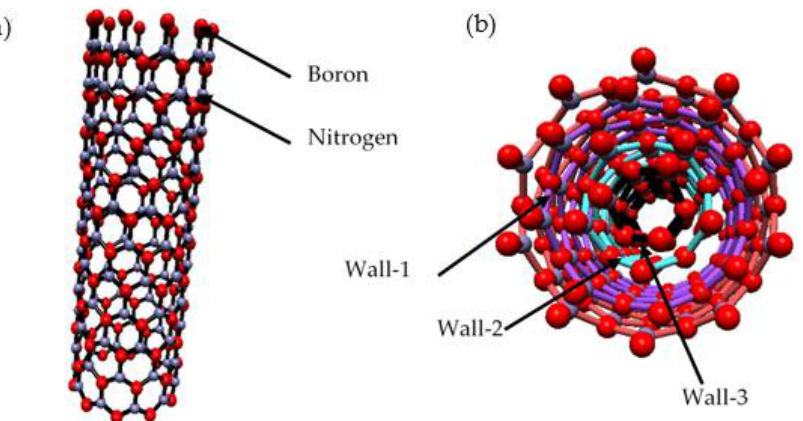
Figure 1. Illustration of ( a ) BNNTs (red — boron, blue — nitrogen); ( b ) multiwalled BNNTs.